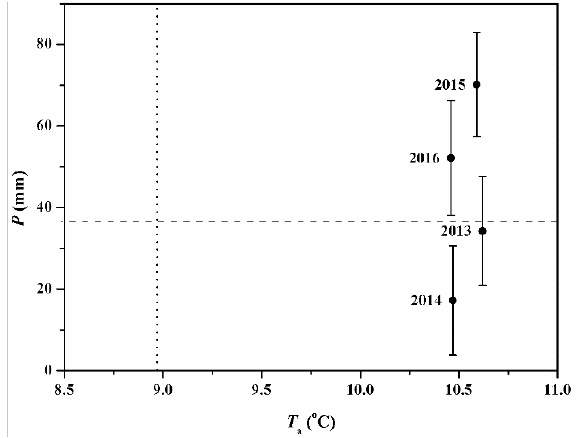
Figure 2. A matrix of annual mean ( ± S.D., vertical bars) air temperature ( T a ) and the annual precipitation ( P ) for the study period 2013–2016 at the lower reach of Heihe River Basin. The vertical and horizontal lines are the mean annual T a and P (1957–2016), respectively.